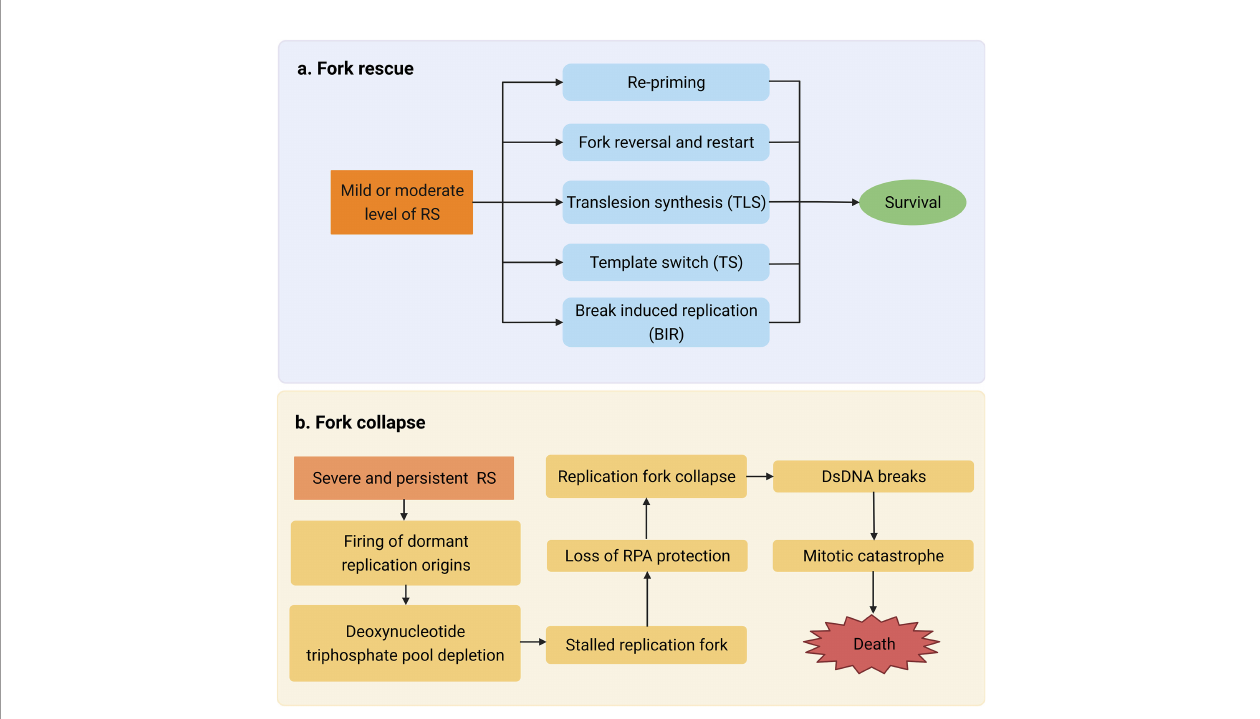
FIGURE 2 | (A) Mild or moderate level of replication stress (RS) activates multiple mechanisms such as re-priming to repair DNA damage. (B) Severe and persistent RS leads to double-stranded DNA (dsDNA) break accumulation and eventually causes mitotic catastrophe which triggers cell